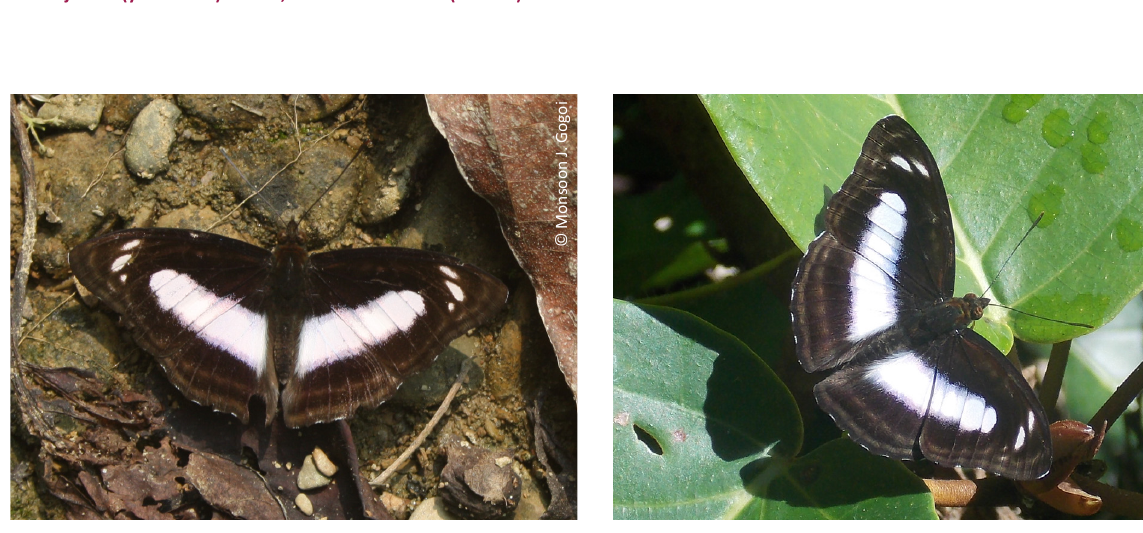
Image 2. Athyma whitei , N.C. Hills, 13 March 2013, up Image 3. Athyma whitei , N.C. Hills, 11 December 2013,